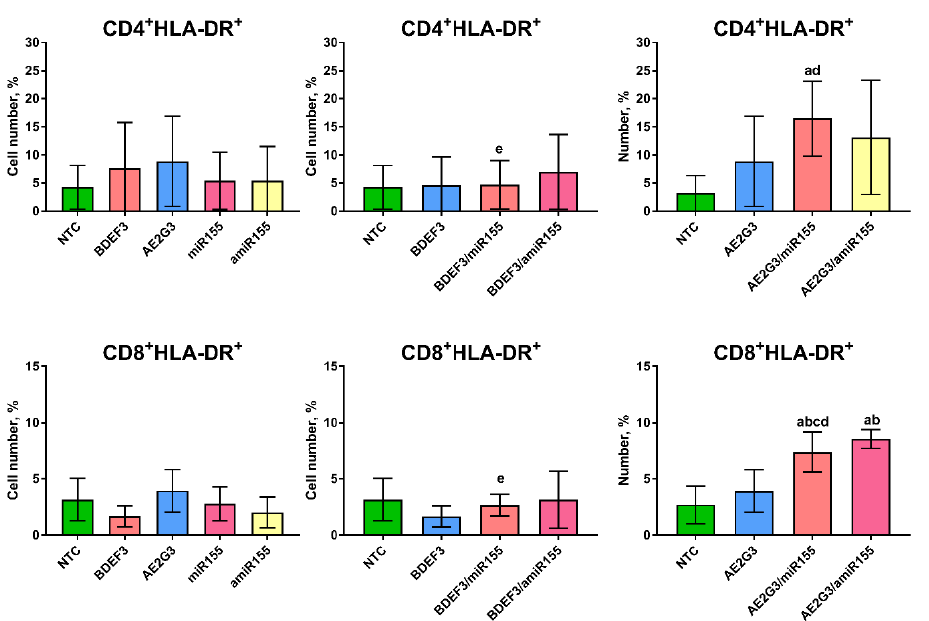
Figure 4. Evaluation of expression of HLA-DR activation marker on CD4+ and CD8+ T-lymphocytes after 72 h of treatment by dendriplexes or their complexes. Mann–Whitney test was used. Letters mark significant differences ( p < 0.05): “a”—in comparison with NTC, “b”—in comparison with treatment by free dendrimer, “c”—in comparison with treatment by free miR, “d”—in comparison with treatment by BDEF33-based complex, “e”—in comparison with by AE2G3-based complex.